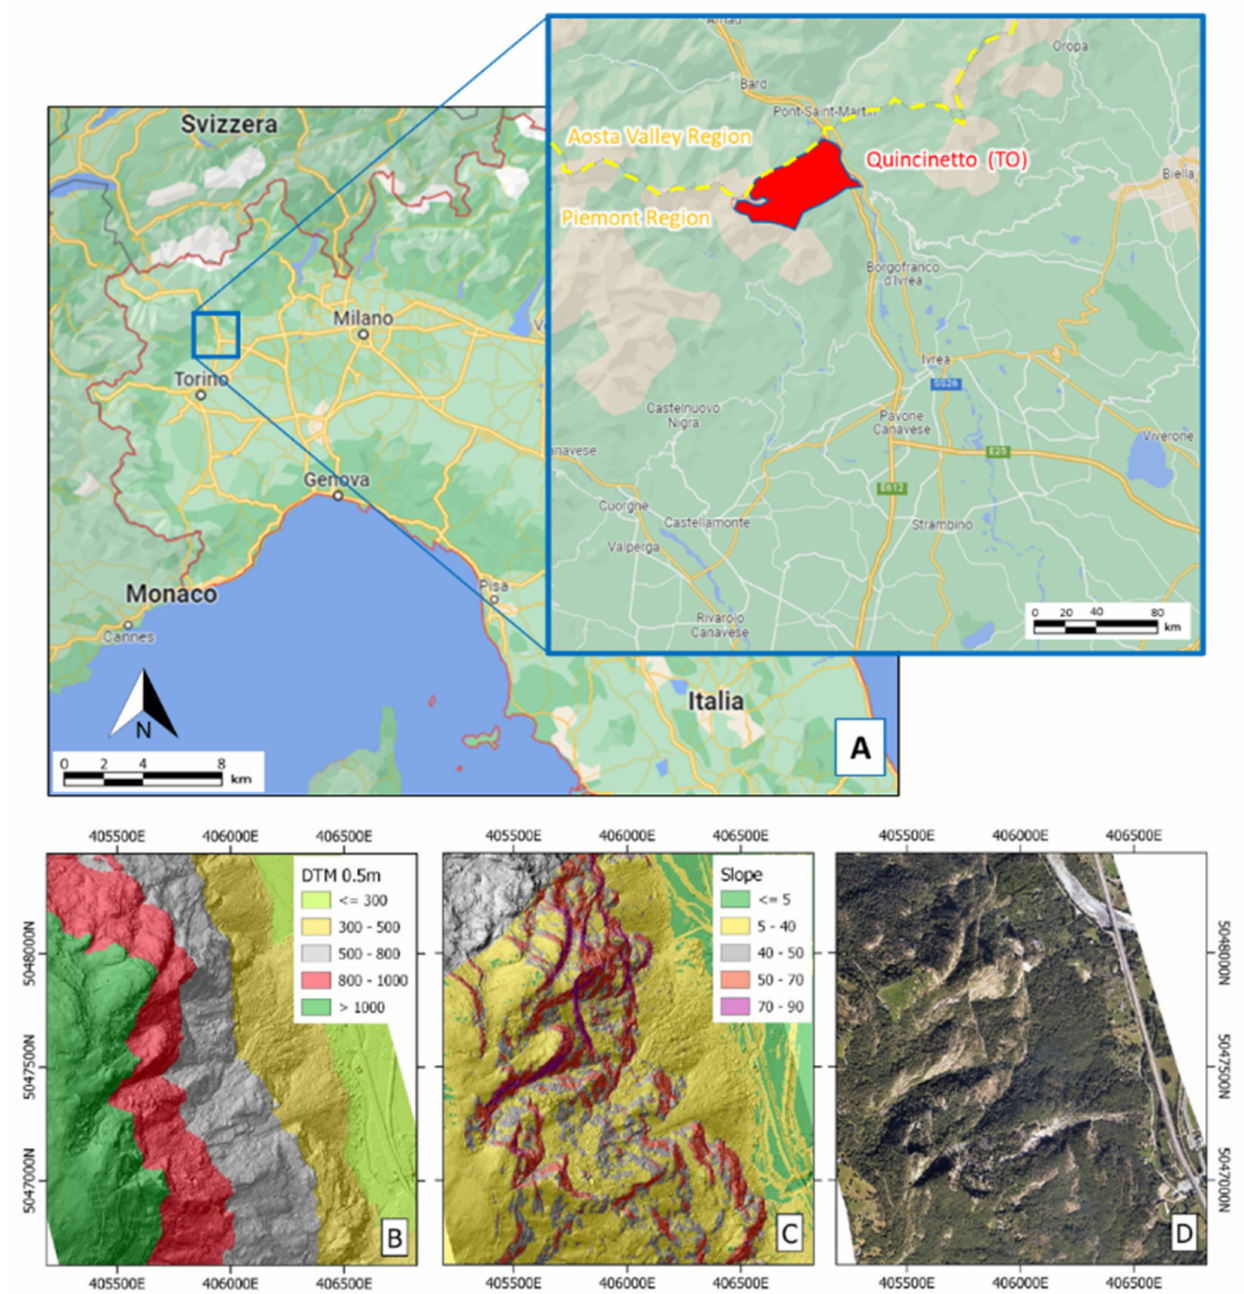
Figure 12. Quincinetto settings. ( A ) General geographic position of the landslide system. High- resolution ( B ) DTM, ( C ) Slope, and ( D ) orthophoto of the landslide